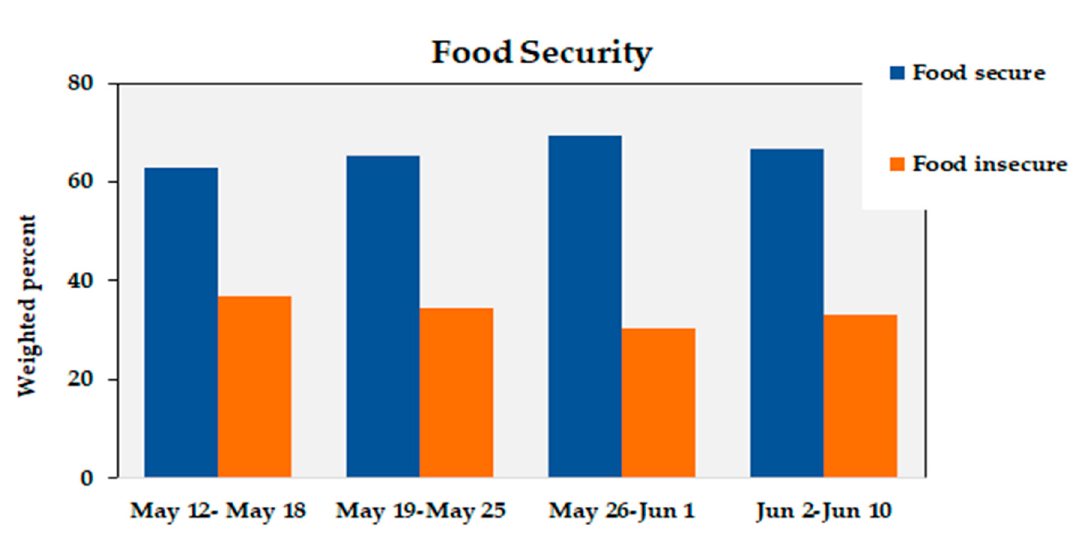
Figure 2. Food security prevalence (top) and change in income (if employment affected) (bottom) as a direct result of the COVID-19 pandemic during the data collection period. 4. Discussion This study sought to assess the prevalence of food insecurity among college students at a university in Texas, US, during the COVID-19 pandemic. Using a multistep food security assessment approach, we found that over 1 in 3 college students experienced food insecurity during the last 30 days. This rate of food insecurity is ~15% higher than the rate of food insecurity previously reported at another US institution in 2019 using the same multistep food security assessment protocol in college students [26]. The high rates of food insecurity reported in the current study appear to be driven by change in living arrangement and/or loss of employment as a direct result of the COVID- 19 pandemic. Specifically, 53.5% college students reported that their employment was directly impacted by the COVID-19 pandemic, and these students had 3.22 (furloughed) to 5.73 (lost part- time shift work) times greater odds of being food insecure than students whose income was not affected by the pandemic. Although food insecurity has increased to a similar extent in nonstudent US households [12,14] during the COVID-19 pandemic, it is worth noting that many college students do not qualify for many federal and state safety net programs (expanded SNAP benefits and federal